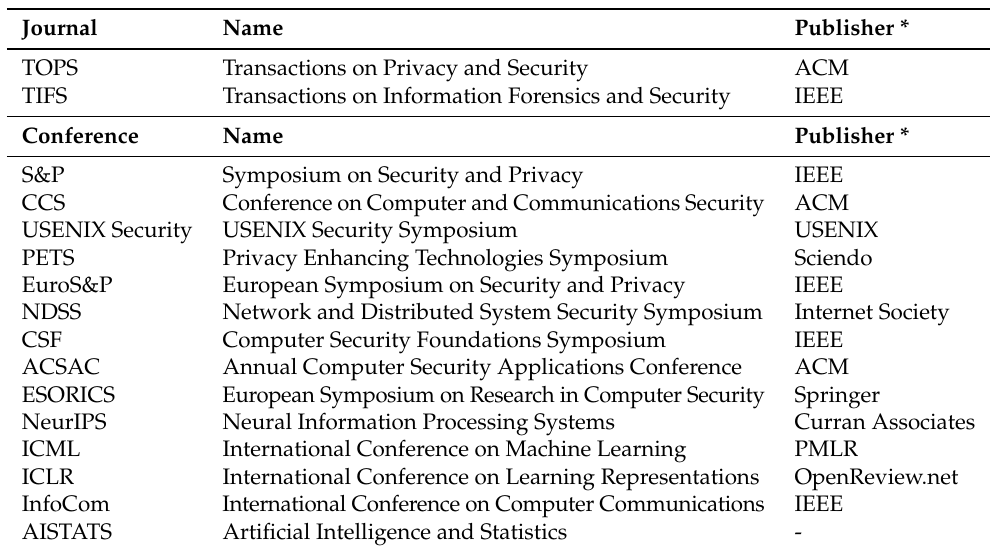
Table 2. Manual search